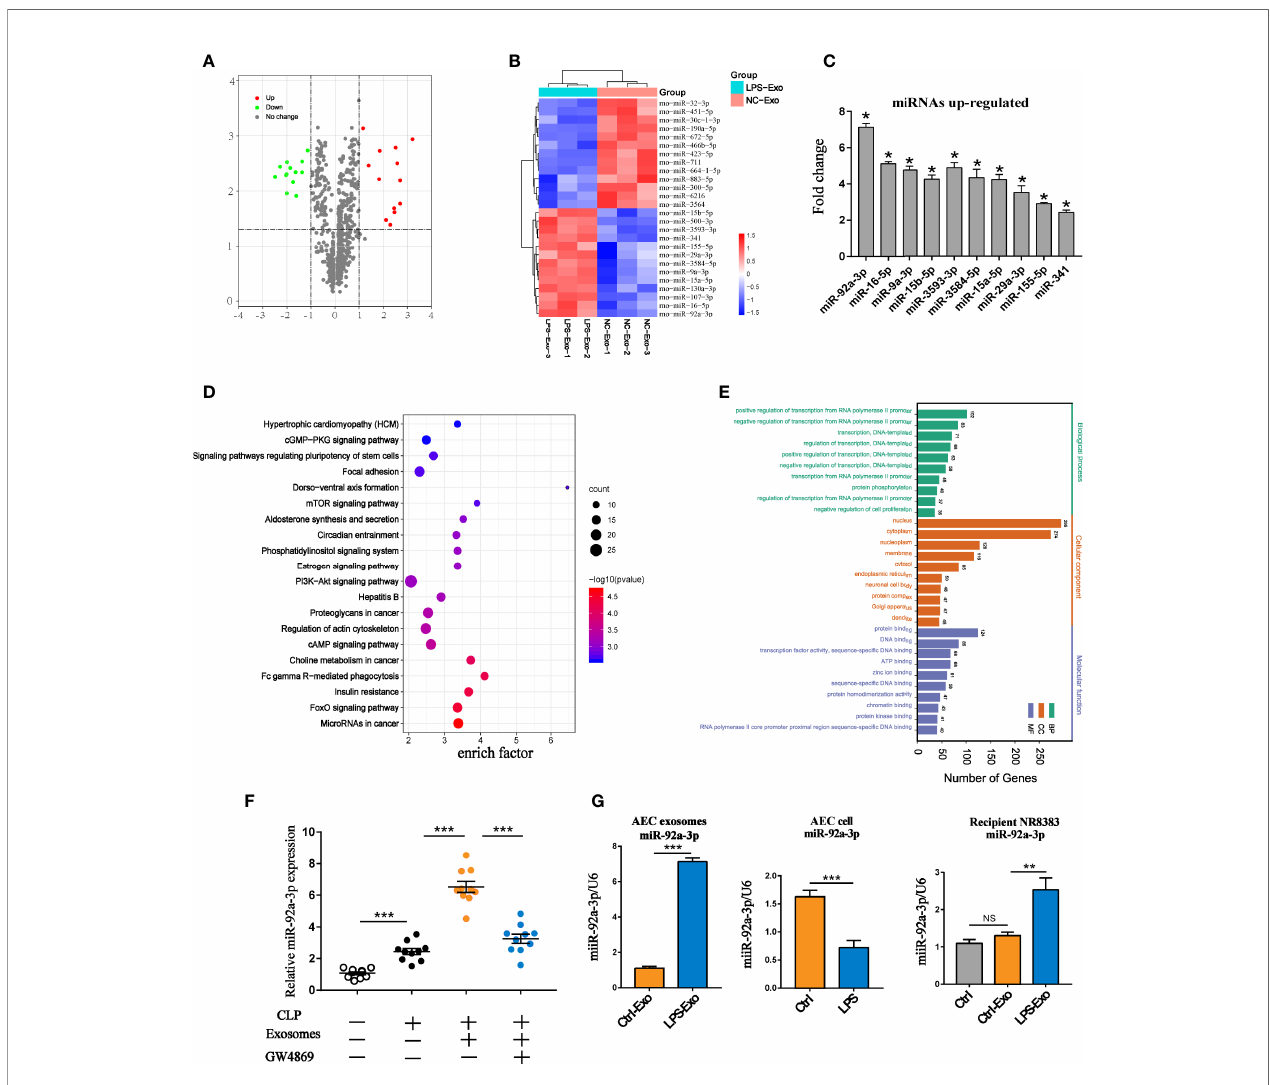
FIGURE 4 | miRNA expression pro fi le of LPS-treated AEC exosomes. (A) The volcano plot of differentially expressed miRNAs between the LPS-Exo and AEC-Exo groups (fold changes ≥ 2 and P<0.05), compared with the Ctrl-Exo group. The miRNAs with upregulated expression are represented by red dots, those with downregulated expression arerepresented by green dots and those with non-signi fi cantly changed expression are shown as grey dots. The vertical lines correspond to upregulation or downregulation by 2-fold, and the horizontal line represents the P value of 0.05. (B) The heatmap shows the differentially expressed miRNAs. (C) Validation of the expression levels of the top 10 upregulated miRNAs in LPS-Exos. Ctrl-Exos were used as a negative control. (D, E) Kyoto Encyclopedia of Genes and Genomes (KEGG) analysis and Gene Ontology (GO) were performed on the predicted target genes of miR-92a-3p. Ctrl-Exos and LPS-Exos represent exosomes isolated from the control and LPS-treated AECs, respectively. (F) The expression of miR-92a-3p in BALF or BALF-derived exosomes isolated from the septic rats. Rats were treated with GW4869 (2.5 µg/g) through airway instillation. An hour post-treatment, CLP procedures were conducted. Sham operated rats were used as negative controls. n=10 for each group. (G) Expression of miR-92a-3p in AEC derived exosomes, AECs and recipient AMs treated with AEC derived exosomes. Data are presented as the mean ± S.E.M. *P<0.05, **P<0.01, ***P<0.001 compared Brtween two groups. NS, no signi fi cance. n=3 per